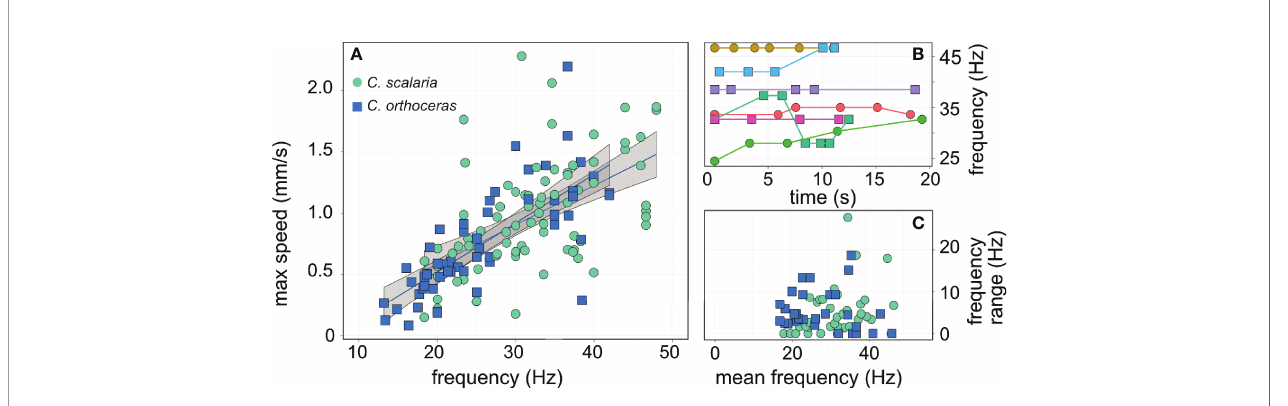
FIGURE 4 | Cilia beat frequency dictates the fl ow speed and thereby encounter rates with prey. (A) cilia beat frequency was positively correlated (R 2 marginal = 0.45; p< 0. 001) with the maximum fl ow speed measured in front of the tintinnid using PTV. (B) examples of cilia beat frequency in different individual tintinnids; this illustrates the fl exibility in cilia beat behavior, where some individuals beat their cilia at the same frequency (e.g. purple, pink lines) whereas other displayed rapid shifts (e.g. blue and green lines). (C) the mean beat frequency was ~30 Hz, however individuals shifted their beat frequency by an average of 4.5 Hz, independent of their beat frequency. The two species are represented by different color (A, C) and symbols (A – C) . Colors in (B) represent different individuals, arbitrarily selected to showcase the behavioral variation.